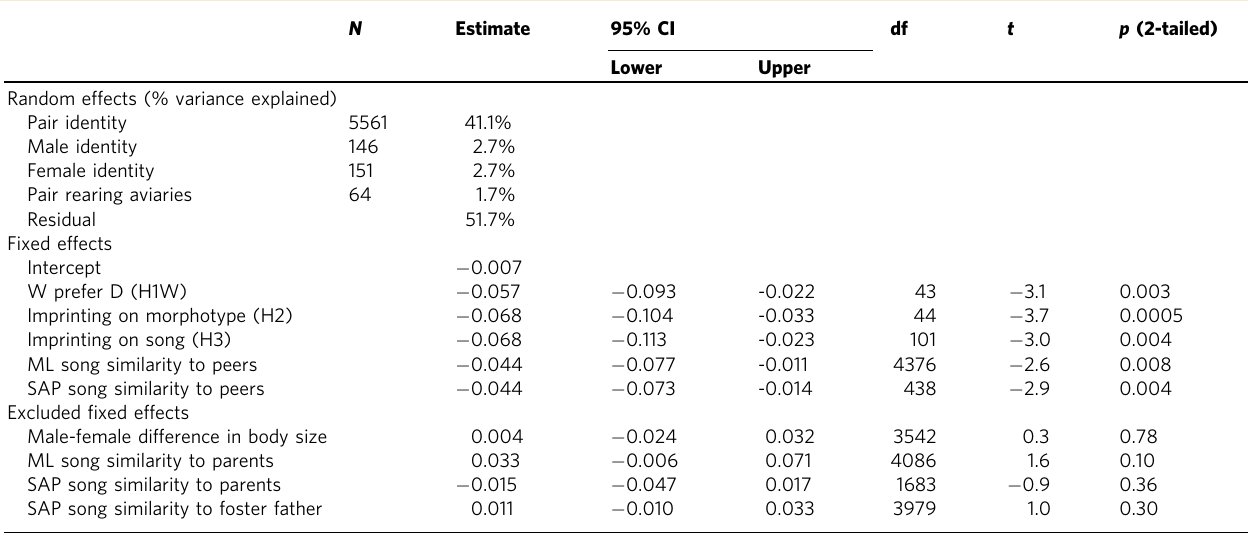
Table 2 Mixed-effect model explaining variation in daily distances between all possible male-female pairs across four aviaries with automated tracking of